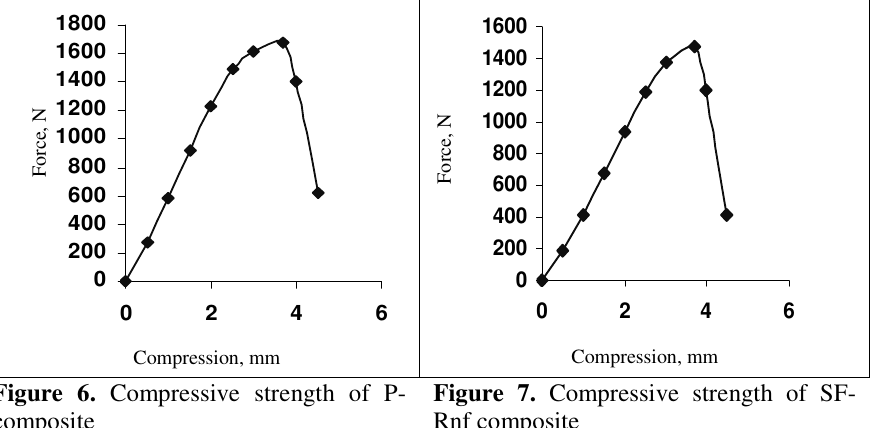
Figure 6. Compressive strength of P- composite